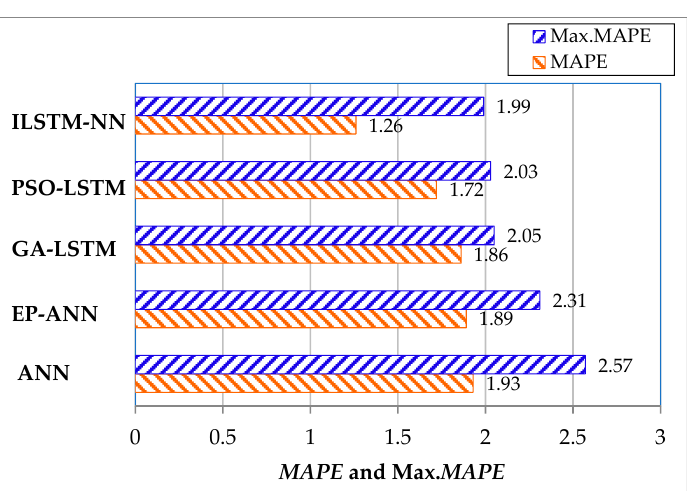
Figure 10. A comparison of MAPE , a typical week and an atypical week’s average load forecast for the four seasons of 2020.